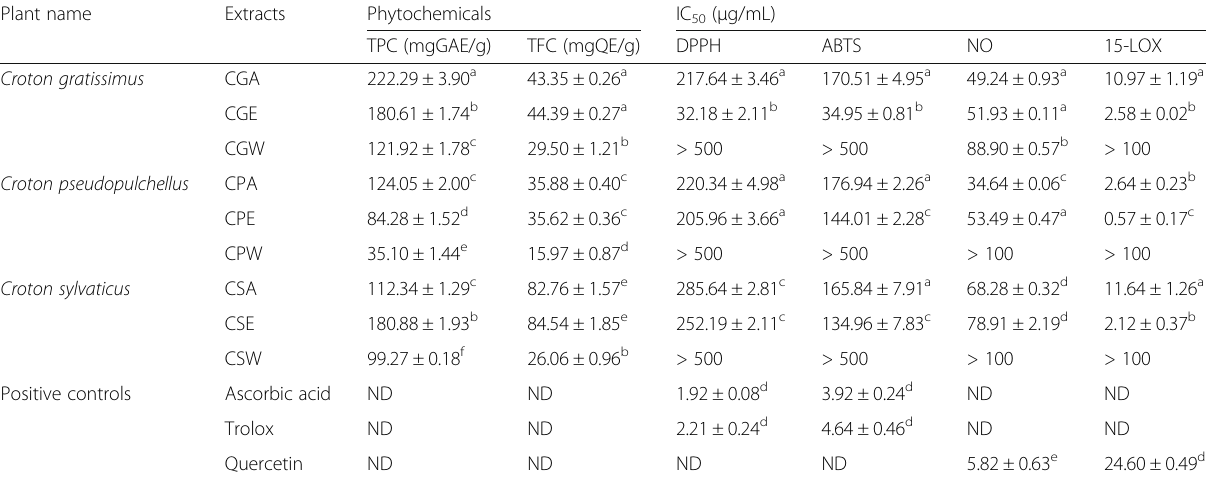
Table 2 Phytochemical content, antioxidant activity, nitric oxide and 15-lipoxygenase inhibition of different extracts from Croton species and positive